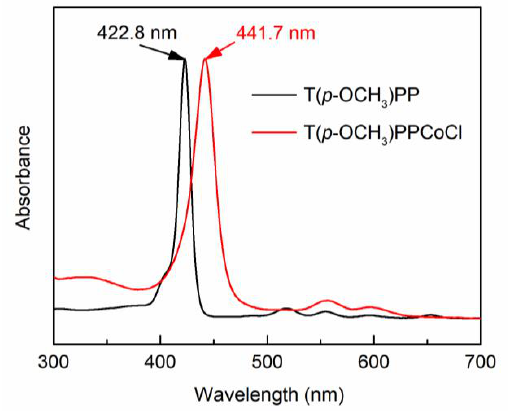
Figure 1. UV-vis spectra of T( p -OCH 3 )PP and T( p -OCH 3 )PPCoCl.